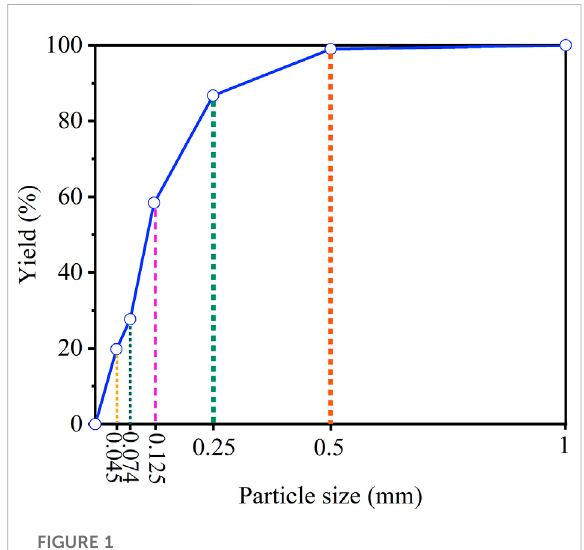
FIGURE 1 Cumulative particle size curve of carbon anode